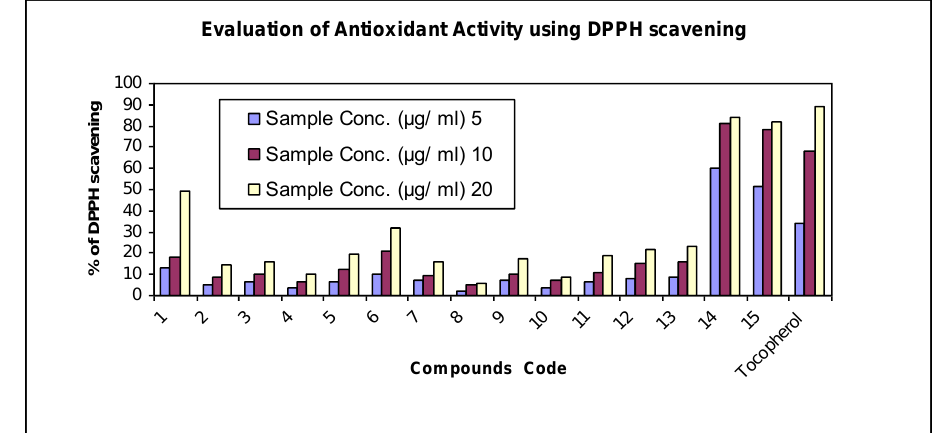
Figure 2. 2,2-diphenyl-1-picrylhydrazyl (DPPH) radical scavenging ability of Tocopherol and all synthesized compounds 1 – 15 . Table 3. The IC 50 value of antioxidant activity for newly synthesized compounds 1 – 15 .